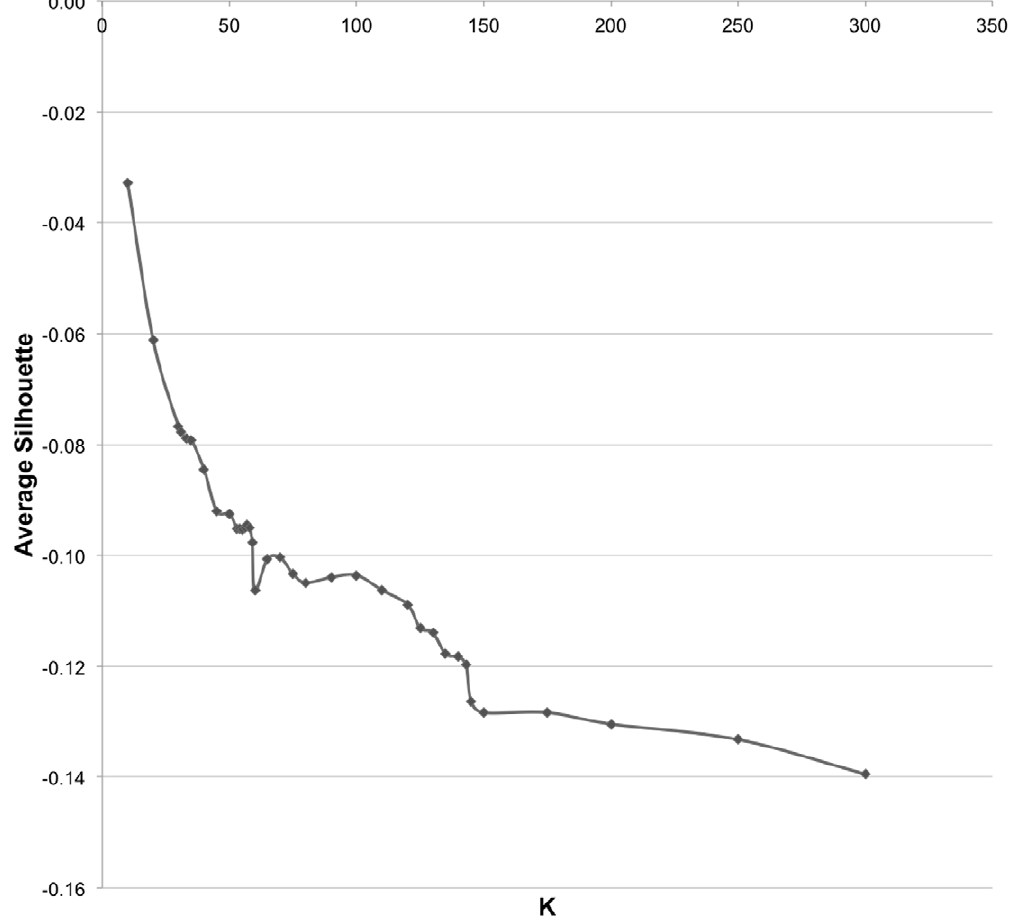
Figure 6. Average Silhouette value against different number of clusters (K). An obvious knee point (K=140) is selected as the number of clusters.